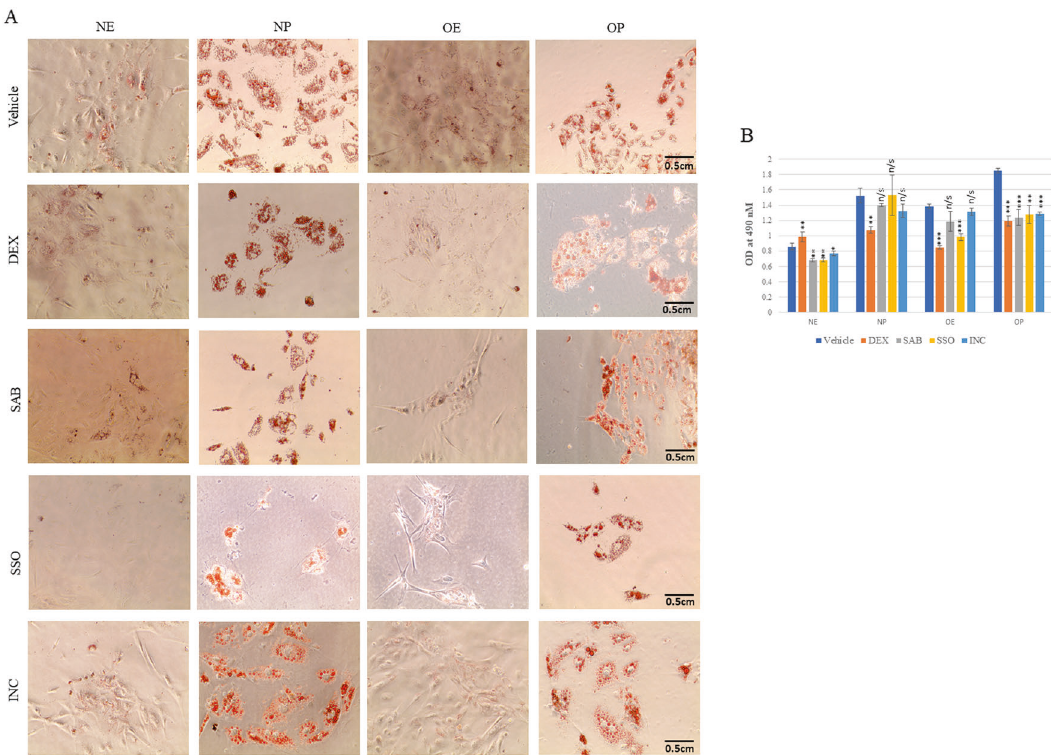
Fig. 7 Pharmacological inhibition of CD36 and CAV1 reduces lipid accumulation in obese iPSCs-derived hepatocytes. A Oil Red O staining showing fat uptake in hepatocytes from (i) NE-normal iPSC-derived, ethanol-treated (ii) NP-normal iPSC-derived palmitate treated (iii) OE- Obese iPSC-derived, ethanol-treated and (iv) OP-Obese iPSC-derived, palmitate treated. On day 17 of hepatocyte differentiation, the cells were treated with dexamethasone (DEX, 10 μ M), Salvianolic Acid B (SAB), 200 μ M), Sulfosuccinimidyl oleate sodium (SSO, 200 μ M), Incadronate (INC, 200 μ M) and vehicle (solvent control) for 72 h. Images were captured using the EVOS XL-Core phase-contrast microscope at ×20 magni fi cation. Scale bar = 0.5 centimeters. B Bar diagrams representing the quantitation of fat uptake as described in A . The bars represent the mean ± SD of three replicates. ‘ * ’ represent the statistical signi fi cance of the data. * P < 0.05, ** P < 0.01, and *** P < 0.001. ns not signi fi